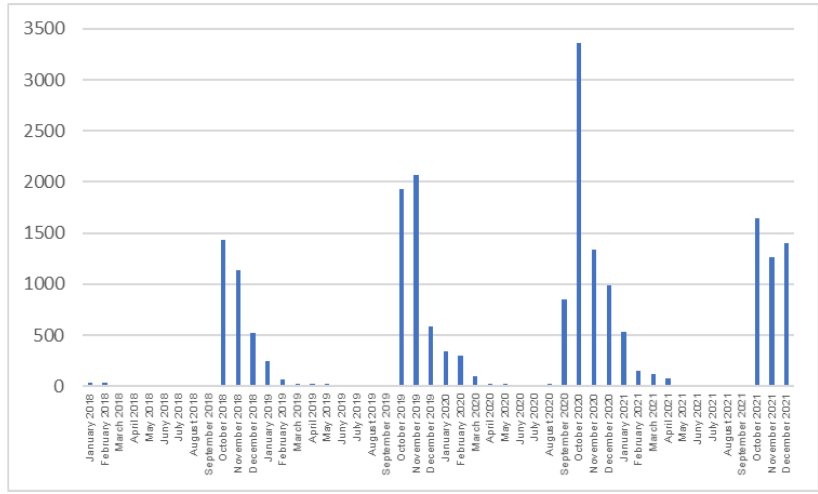
Figure 3. Number of anti-influenza vaccinations among Polish soldiers.